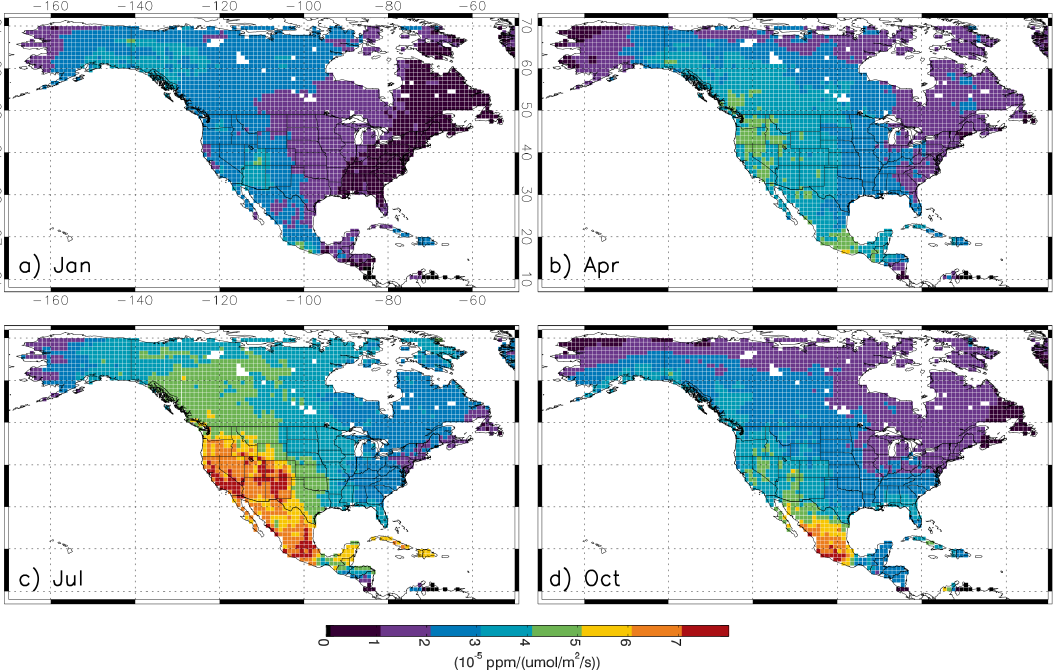
Figure 5. Jacobian values averaged over all observations and weekly flux intervals for the 1.57µm weighting function in (a) January, (b) April, (c) July, and (d) October.